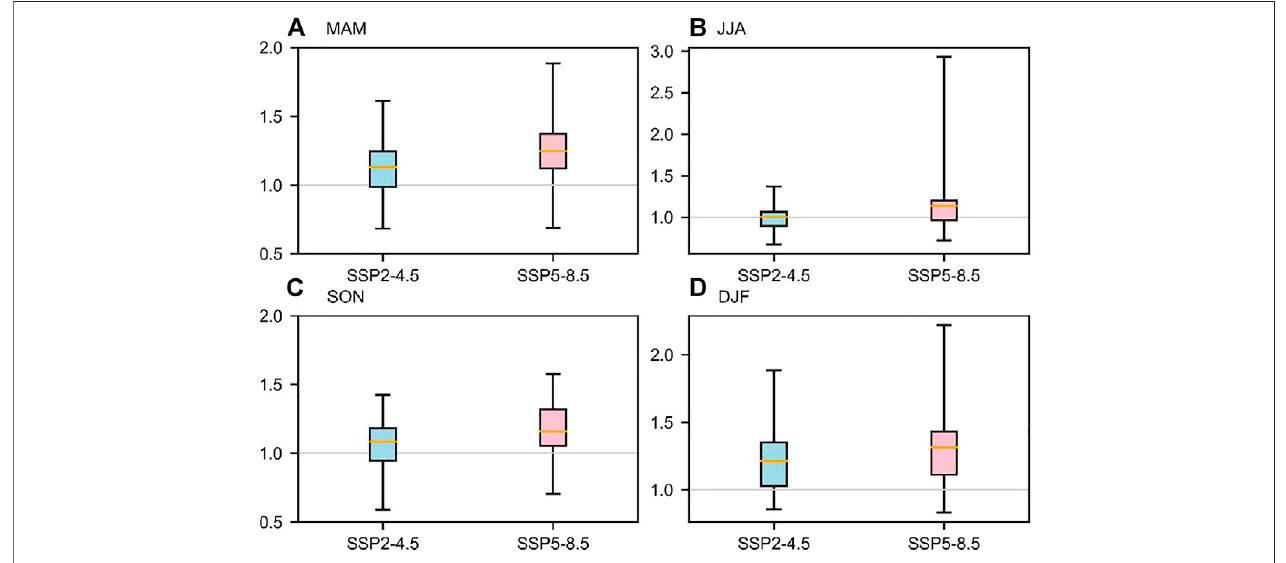
FIGURE 11 | Same as Figure 9 , but for the projected ratio of APO standard deviation in (A) spring, (B) summer, (C) autumn and (D)